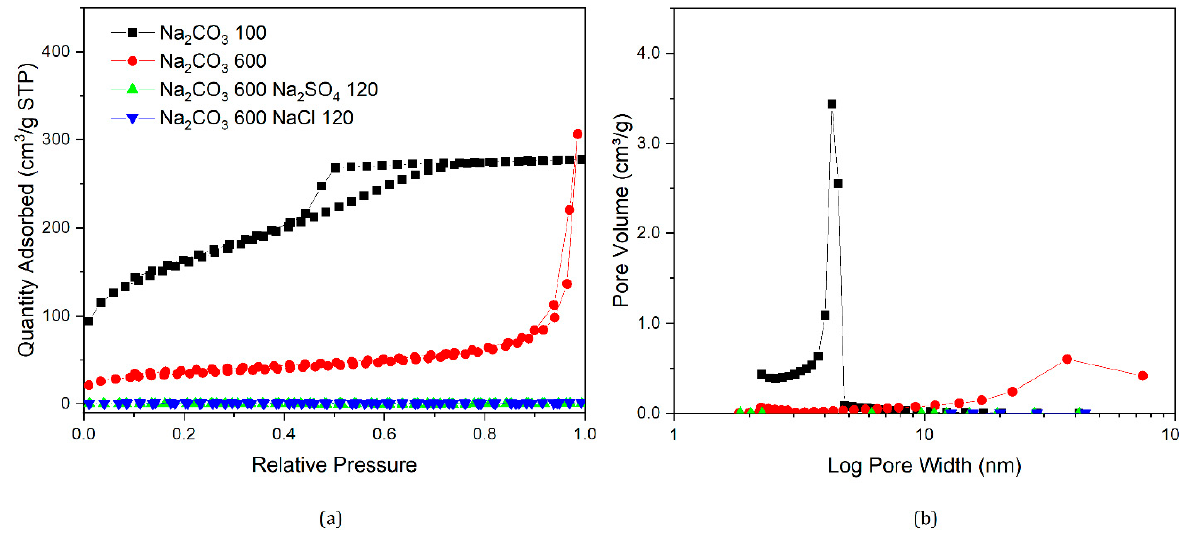
Figure 9. Nitrogen sorption isotherms of gels with modified catalyst composition ( a ) and corresponding pore size distributions ( b ).